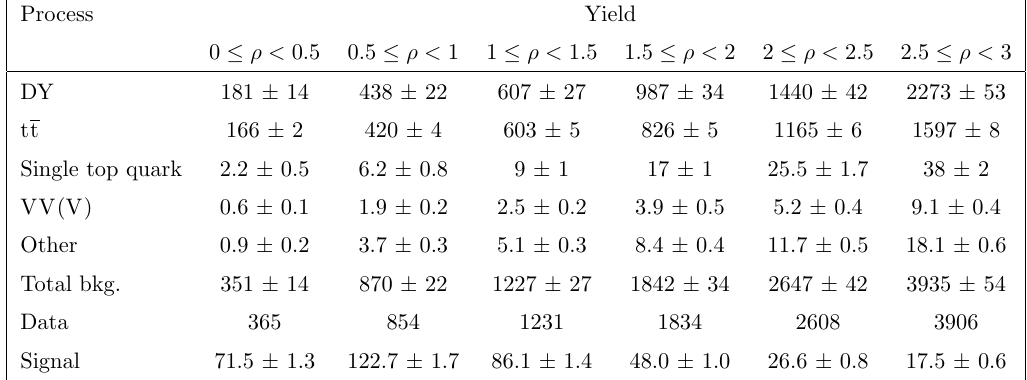
Table 1 . Expected and observed event yields prior to the (cid:12)t in the signal region with m and m = 200 GeV for each elliptical bin. The signal is normalised to its theoretical cross section A for the Type-II 2HDM benchmark tan (cid:12) = 1 : 5 and cos( (cid:12) (cid:0) (cid:11) ) = 0 : 01. The ee and (cid:22)(cid:22) categories are summed. The reported uncertainties are statistical only.